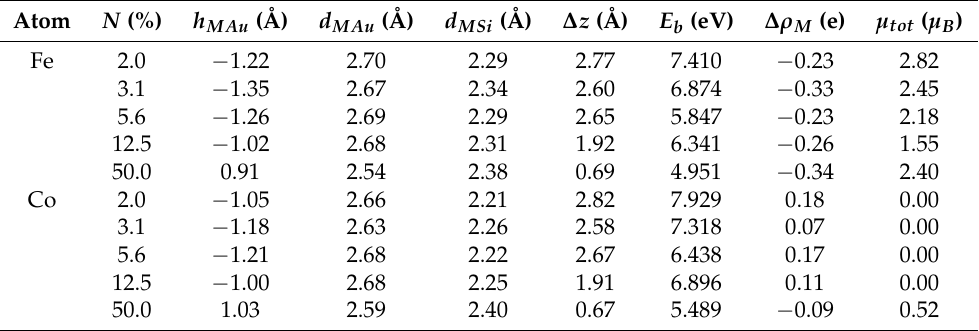
Table 2. Structural and energetic parameters for Fe- and Co-substituted silicene/Au system at their different concentrations N : the z coordinate of the M atom with respect to the Au plane ( h MAu ), the bond length between the M atom and its nearst Au atoms ( d MAu ), the bond length between the M atom and its nearest Si atoms ( d MSi ), thickness of the silicene/Au structure defined as the difference between the largest and smallest z coordinates of Si and Au atoms ( ∆ z ), the binding energy of the M atom ( E b ), charge transferred from silicene to the M atom ( ∆ ρ M ), total magnetic moment of the system ( µ tot ) in units of Bohr magneton ( µ B